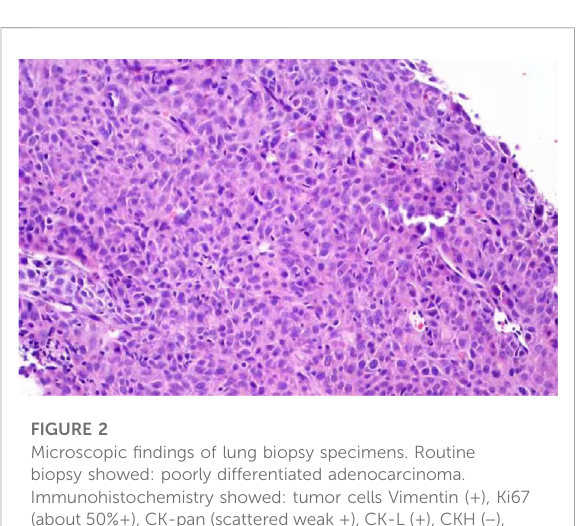
Microscopic fi ndings of lung biopsy specimens. Routine biopsy showed: poorly differentiated adenocarcinoma. Immunohistochemistry showed: tumor cells Vimentin (+), Ki67 (about 50%+), CK-pan (scattered weak +), CK-L (+), CKH ( −